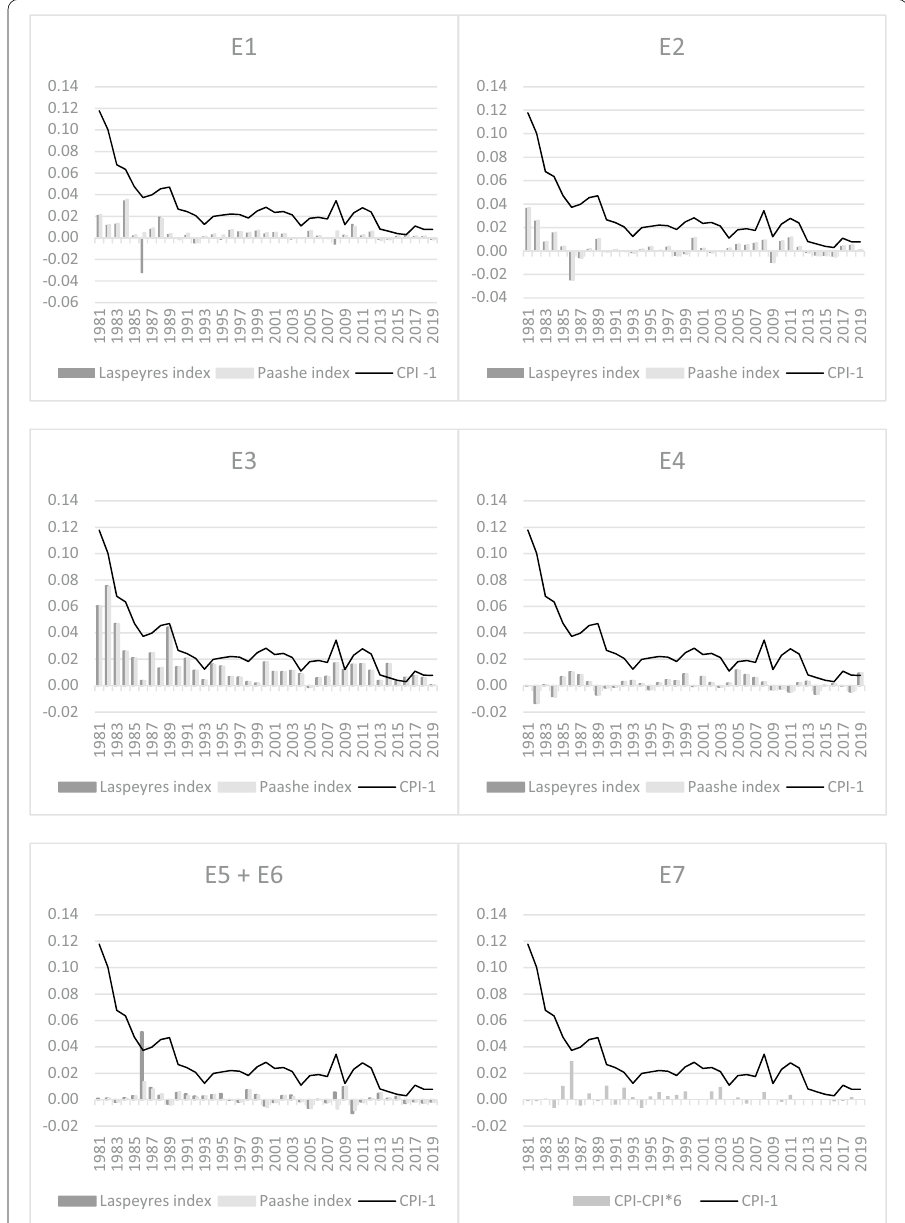
Fig. 1 Danish CPI and its components. The sum of E 1… E 7 equals to CPI-1. Source: own calculations based on Statistics Denmark